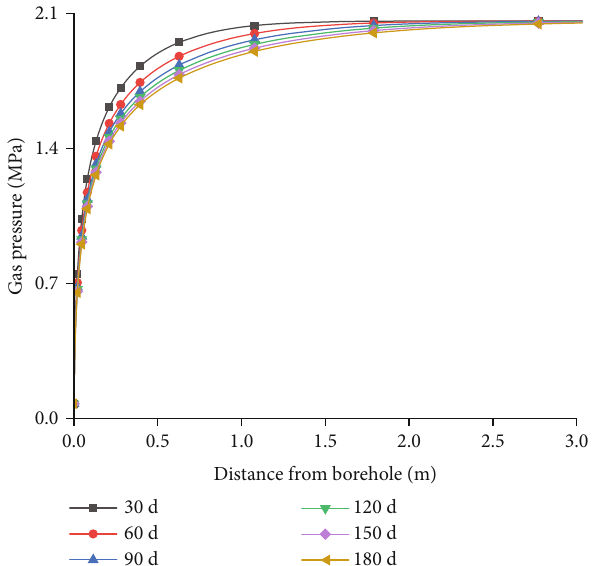
Figure 18: Variation curves for gas pressure before unloading disturbance.